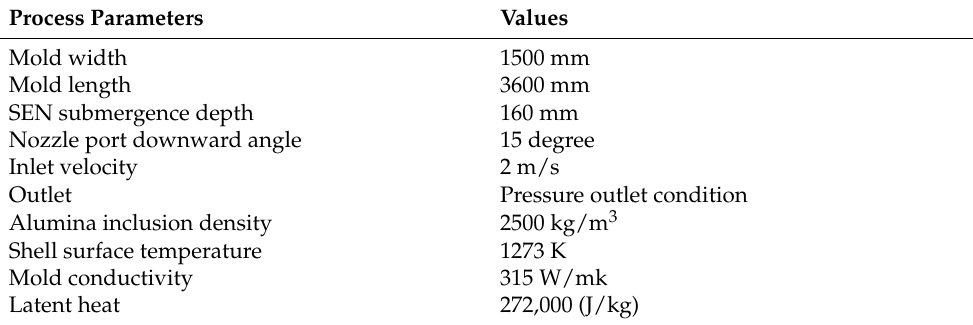
Table 3. Process parameters